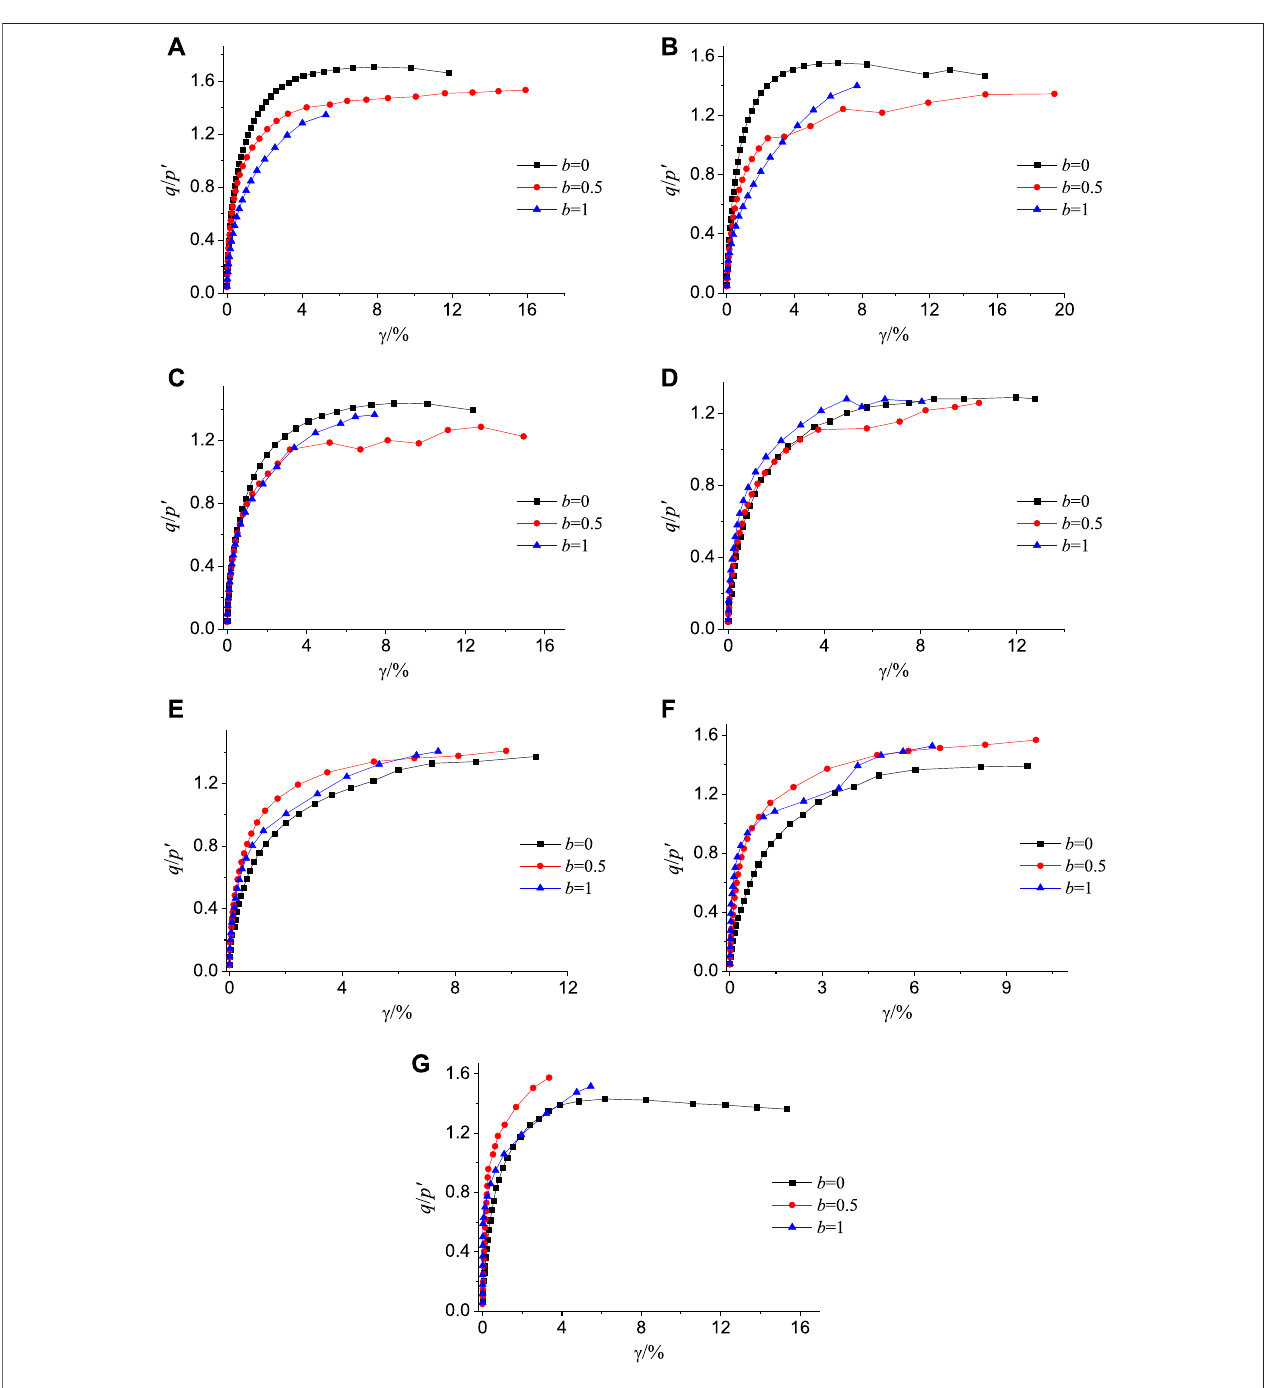
FIGURE6| Curvesofgeneralizedshearstressratio-straindiagramatdifferentintermediatestressparameters: (A) α =0 ° ; (B) α =15 ° ; (C) α =30 ° ; (D) α =45 ° ; (E) α = 60 ° ; (F) α = 75 ° ; (G) α = 90 °